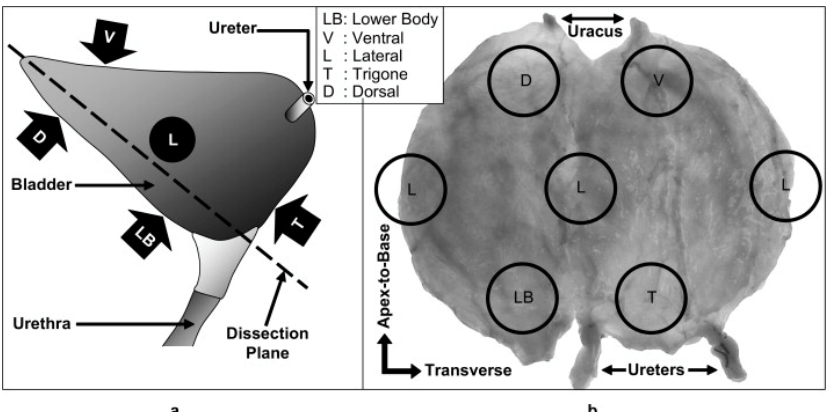
Figure 8. Shows locations of samples obtained. ( a ) Anterior-posterior plane diagram of the bladder indicating the sample localization. ( b ) Cut-opened porcine bladder showing sample localisation. Directions indicated where apex-to-base is also considered as longitudinal and transverse direction also considered as circumferential. Figure obtained with permission from [48].